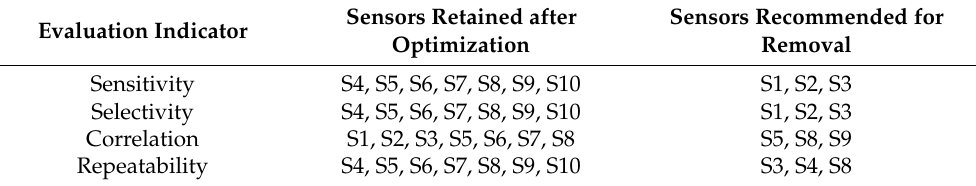
Table 3. Optimization of the initial sensor array based on different evaluation